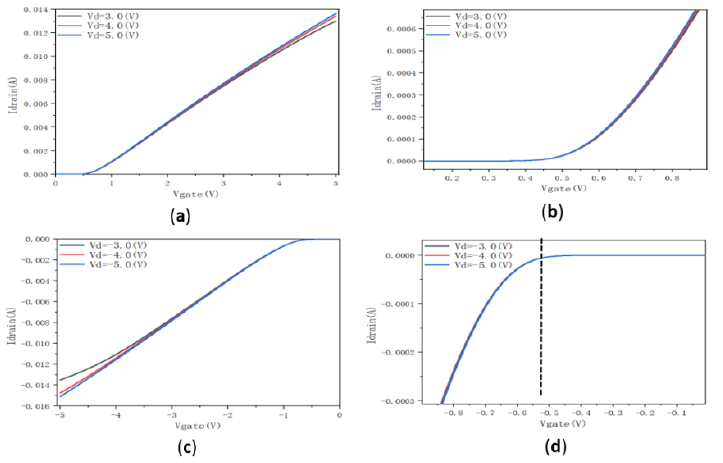
Figure 6. ( a )NMOS transfer characteristic curve; ( b ) Partially enlarged diagram of NMOS transfer characteristic curve; ( c ) PMOS transfer characteristic curve; ( d ) Partial enlargement of PMOS transfer characteristic curve.